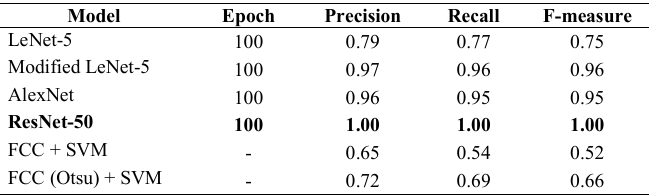
Fig. 11 Comparison of the classification methods in the testing stage TABLE 2 R ESULTS OF C LASSIFICATION M ETHODS AT THE T ESTING S